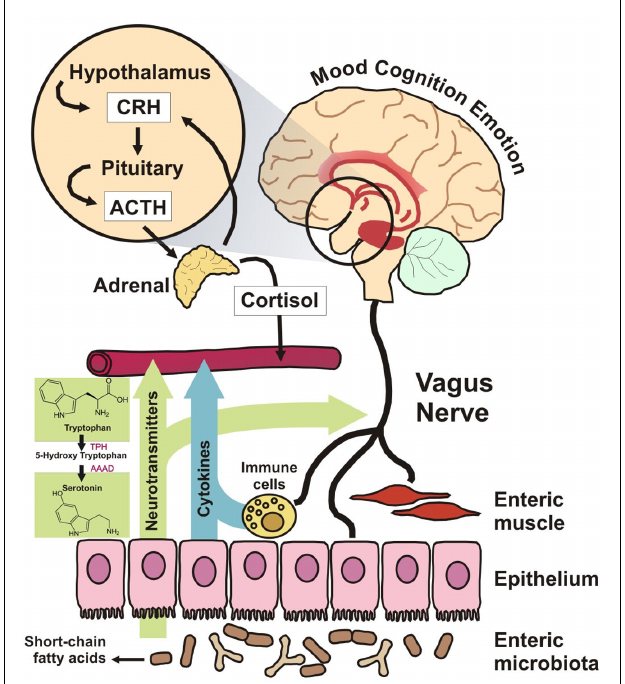
FIGURE 3 | Proposed mechanisms of action. There are a variety of proposed mechanisms, including both humoral and neural routes, through which the microbiota can modulate signaling along the brain–gut axis. For example, recent studies suggest a role for both the vagus nerve and modulation of systemic tryptophan levels in relaying the influence of both resident and exogenous microflora along this bidirectional communication